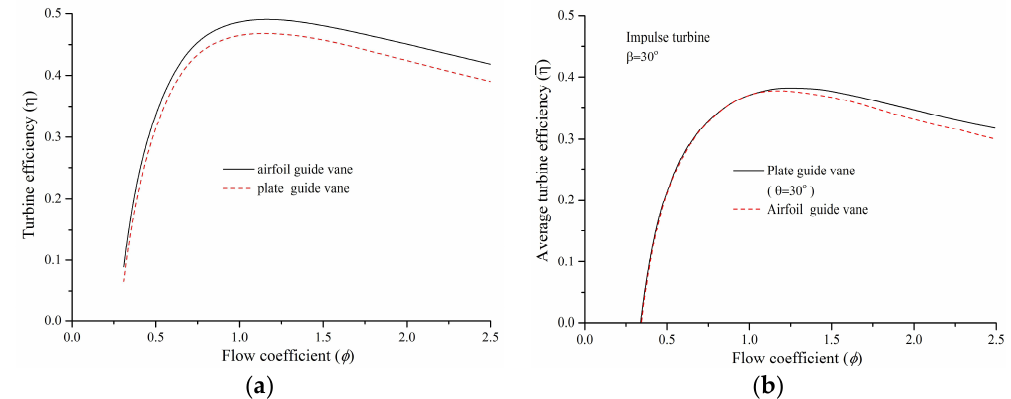
Figure 7. Influence of the guide vane type on the efficiency. ( a ) Present numerical study and ( b ) previous experimental results [5].